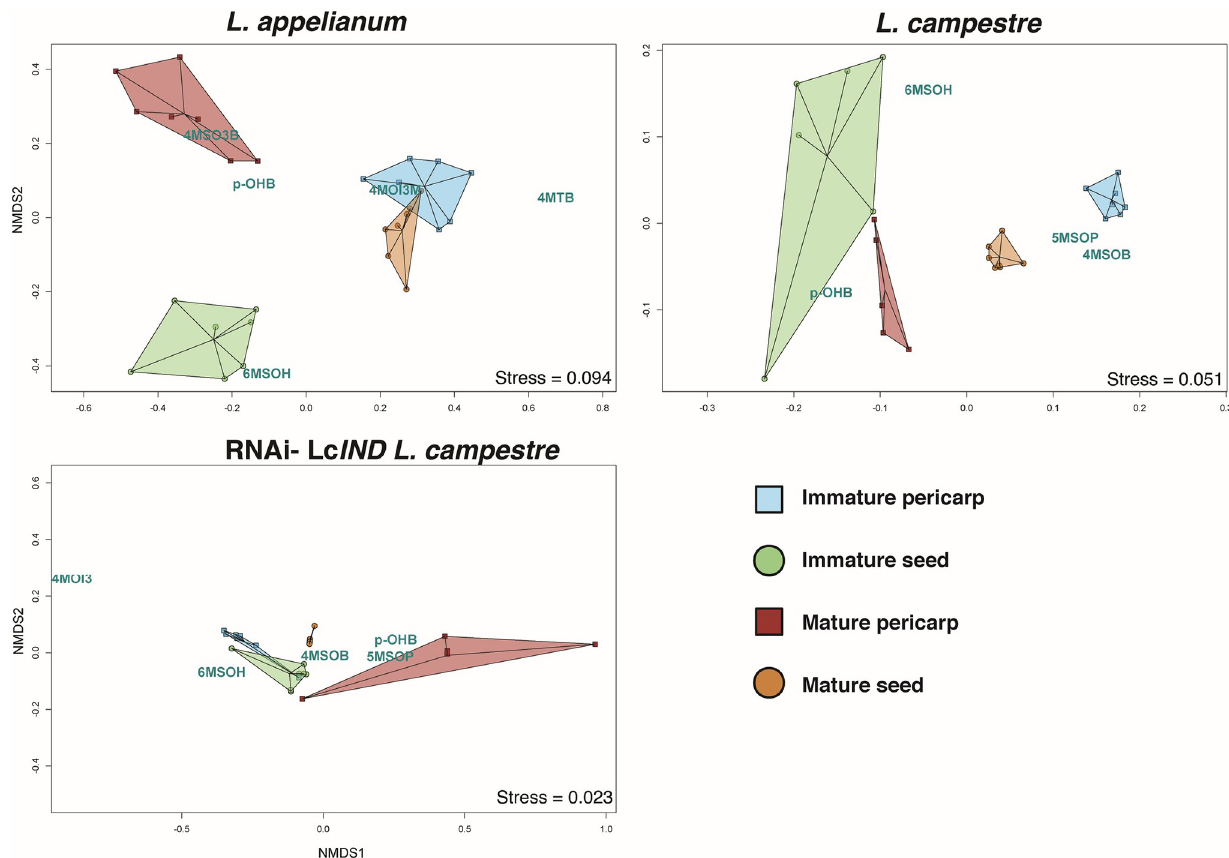
Fig 4. Non-Metric Multidimensional Scaling (NMDS) 2D ordination plots resolve the distinction of glucosinolate composition between diaspores of different ontogenetic stages (immature vs mature) and tissue types (pericarp vs seed) in Lepidium . The composition and concentration of glucosinolate (GSLs) were analysed to distinguish their clustering patterns among immature (shades of green polygons) and mature (shades of brown polygon) pericarps (squares) and seeds (circles). Biological replicates (n = 6–7) within each group were displayed as ordispiders, which are connected from their corresponding centroids, and the relative distance between the points represent the Kulczynski dissimilarity index computed from the chemical data transformed by Wisconsin double-standardisation method. The relative proximity of the GSLs (blue text) to the clusters signifies their potential resolving capacity within each plot. Stress values (shown in the bottom right of each plot) represent the overall resolution power of the NMDS analysis for each plot ( < 0.05 = excellent, < 0.1 = good).